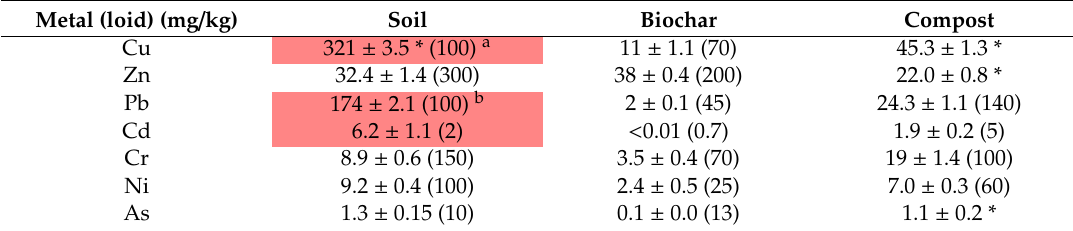
Table 2. Trace element content in substrates.